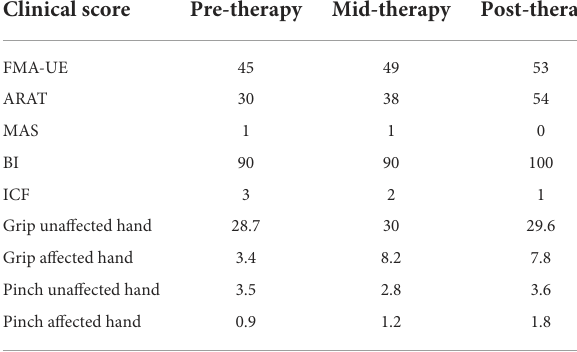
TABLE 1 Upper limb motor function and strength. Higher scores imply less upper limb motor impairment (FMA-UE, ARAT), higher independence for performing activities of daily living (BI), higher upper extremity disability (ICF), or higher spasticity (MAS). Clinical score Pre-therapy Mid-therapy Post-therapy